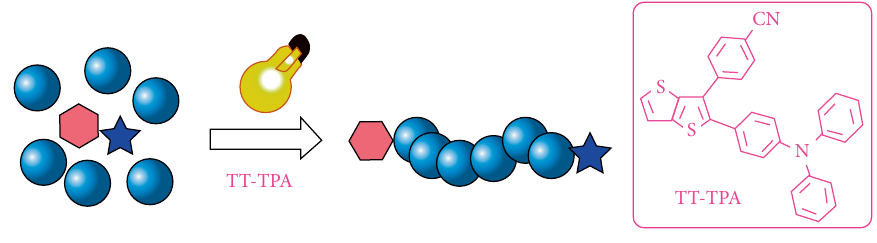
Figure 11: Photoinduced metal-free atom transfer radical polymerization using highly conjugated thienothiophene derivatives. (Adapted with permission from Ref.